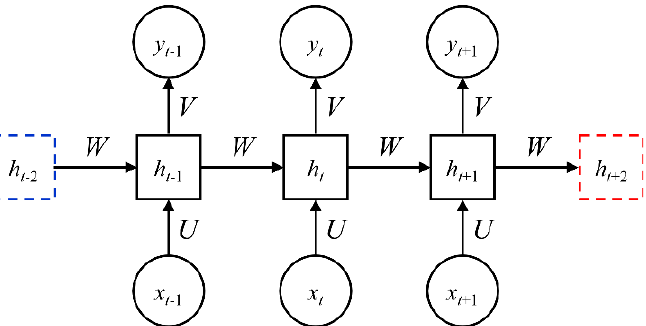
Figure 2. The schematic of the RNN model.